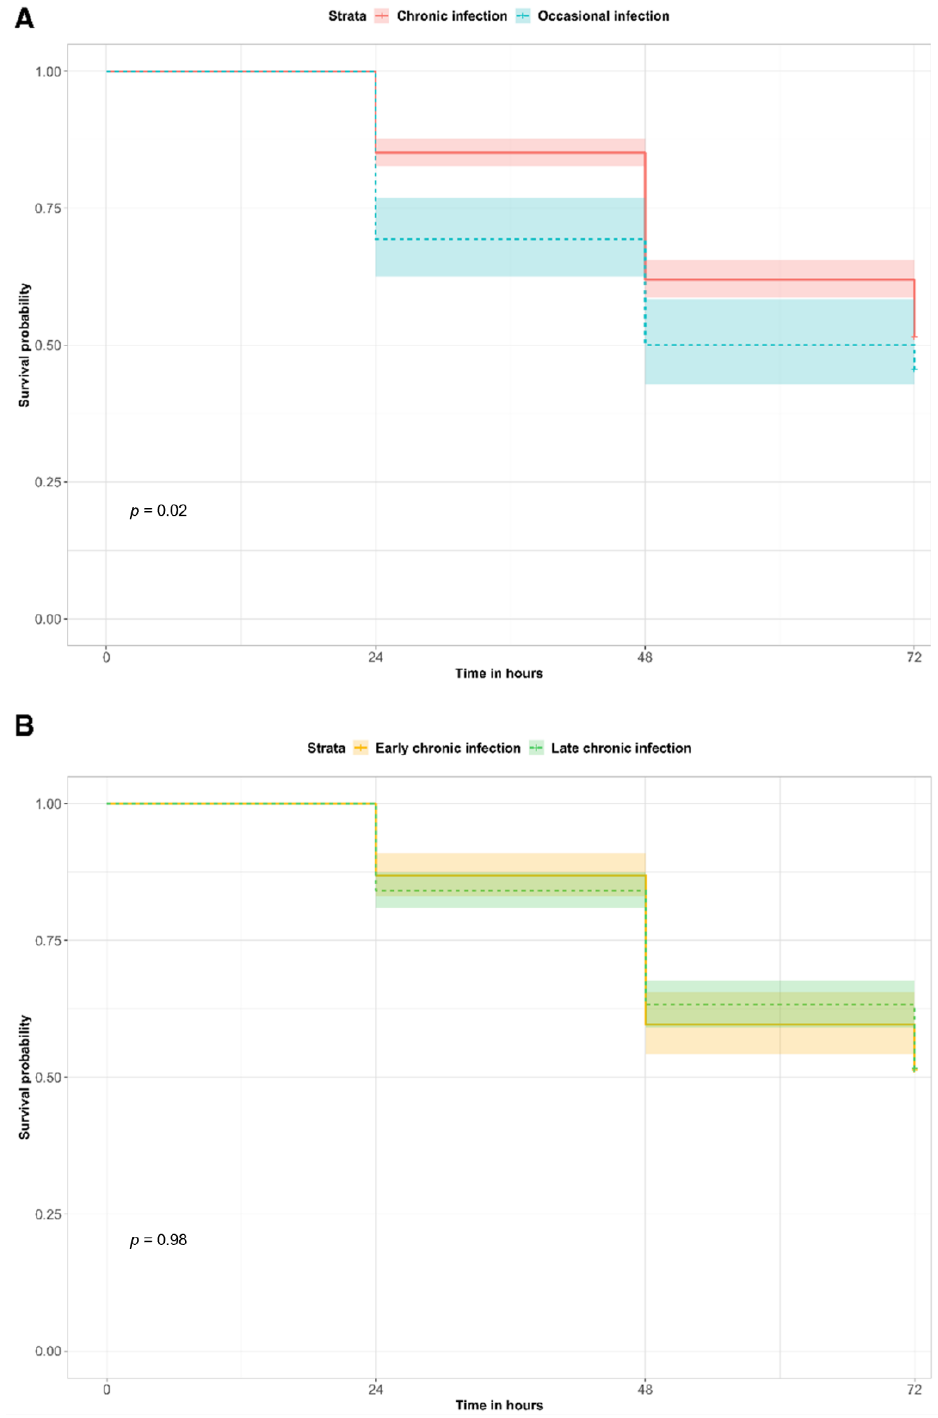
Figure 1. G. mellonella survival curve for virulence testing. The survival probabilities of G. mellonella larvae infected with chronic or occasional infection isolates ( A ) and with early or late chronic infection isolates ( B ) are reported at each time point. The p -values of the survival curve comparisons are indicated with p .